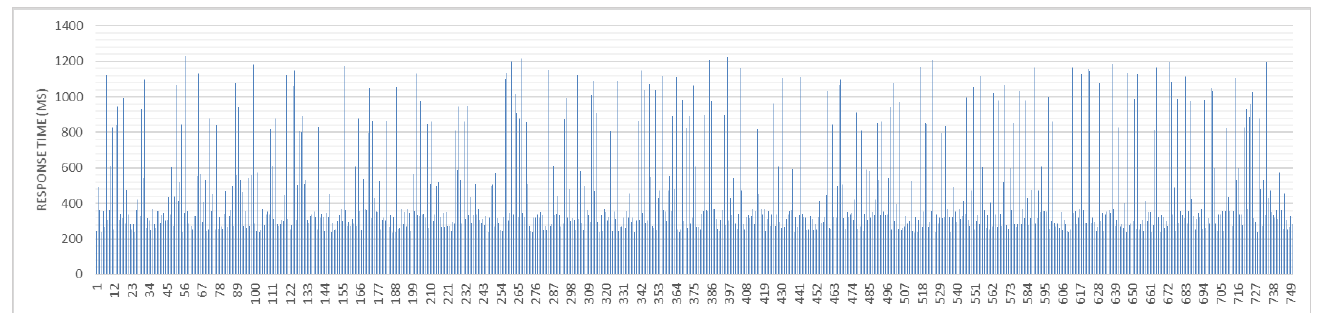
Figure 12. Response time over a period of 12.5 h when microservices were deployed using the arbitrary distribution model.